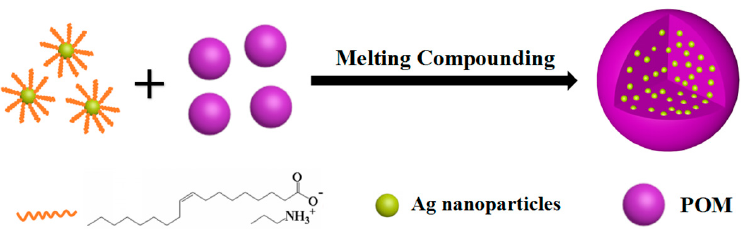
Figure 1. Synthesis procedure of polyoxymethylene (POM)/silver (Ag) nanocomposites.